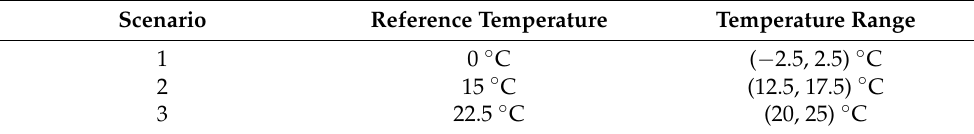
Table 7. Temperatures of the battery